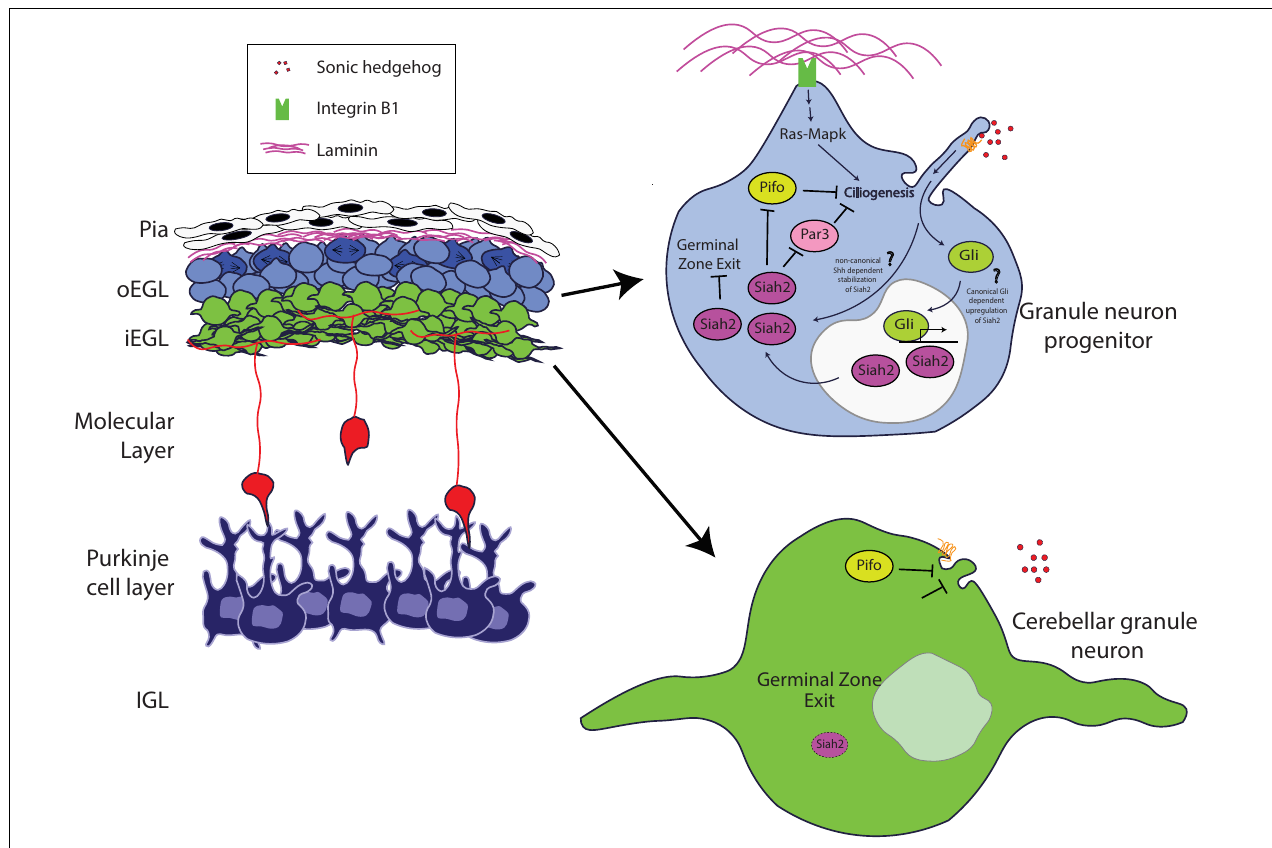
FIGURE 1 | Schematic of how Siah2 is regulated in developing CGNs. The laminin-rich basement membrane surrounding the oEGL in a developing cerebellum promotes Shh signaling driven primary ciliogenesis in GNPs via Integrin β 1—Ras/Mapk signaling. The primary cilium allows GNPs to sense the Shh mitogen and activate the Shh pathway to maintain Siah2 expression which in turn promotes GZ occupancy by inhibiting GZ exit. Siah2 acts in a feed-forward mechanism to maintain mitogen sensitivity by promoting primary ciliogenesis through the antagonism of a key cilia disassembly proteins Pifo and Dbn, and the polarity inducer Pard3. As GNPs leave the oEGL, the lack of trophic support leads to the disassembly of the primary cilium and loss of sensitivity to Shh, which promotes CGN